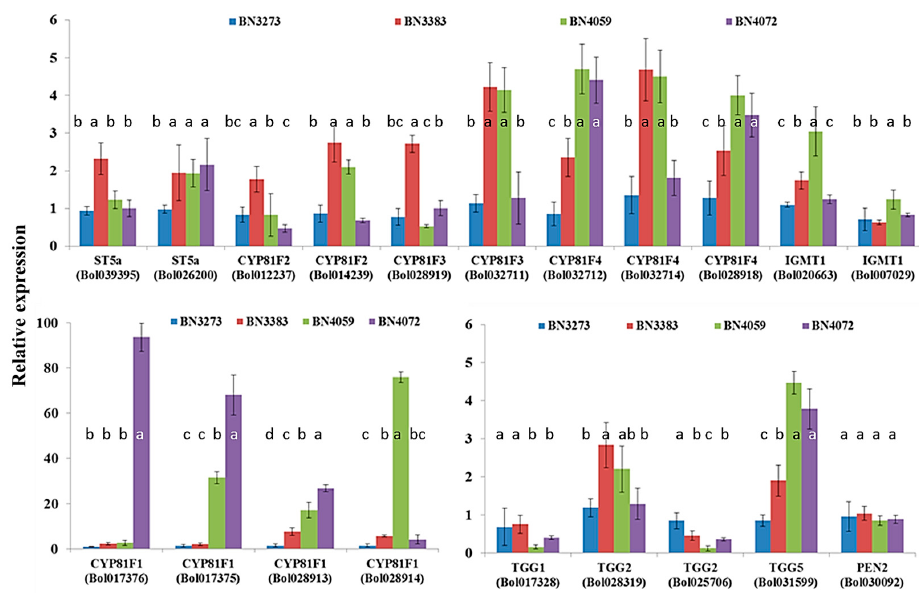
Figure 5. Relative expression level of indolic glucosinolate biosynthesis- and break-down-related genes in four cabbage inbred lines of B. oleracea. Vertical bars indicate the standard deviation of the means of nine observations. Different letters (a, b, c) indicate statistically significant difference between inbred lines.